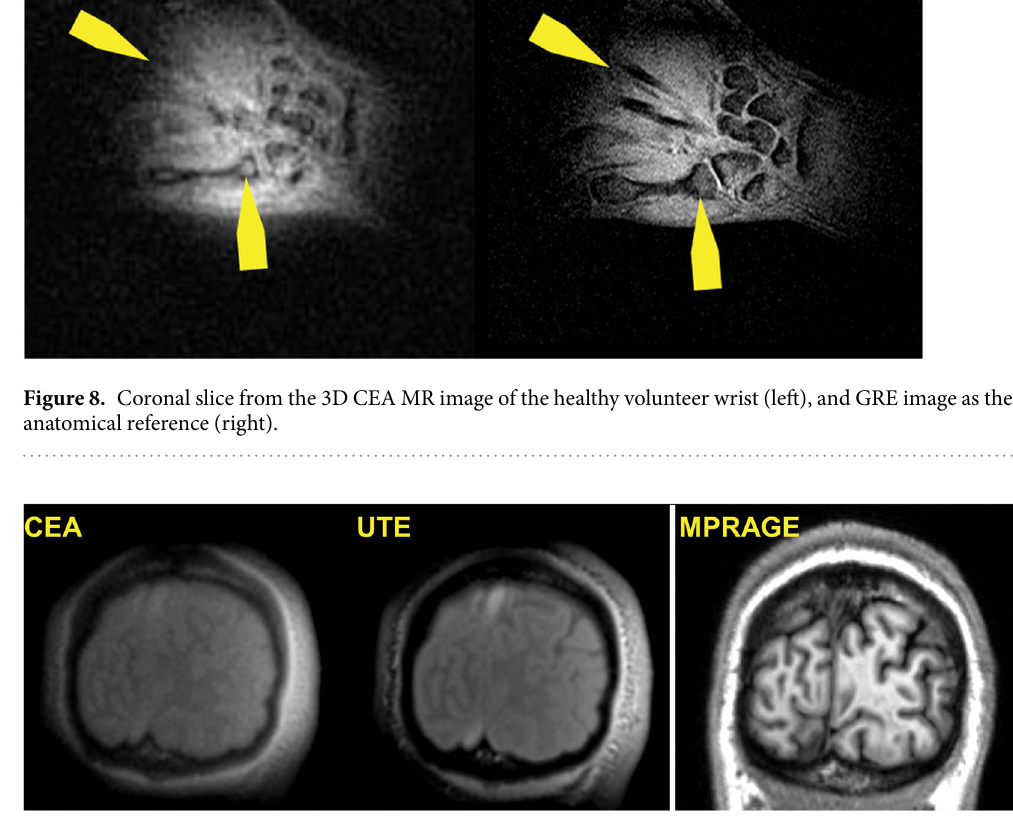
Figure 9. Coronal slices from the 3D CEA and UTE image data of a human head registered on a previously acquired T 1 -weighted MPRAGE data set as the anatomical